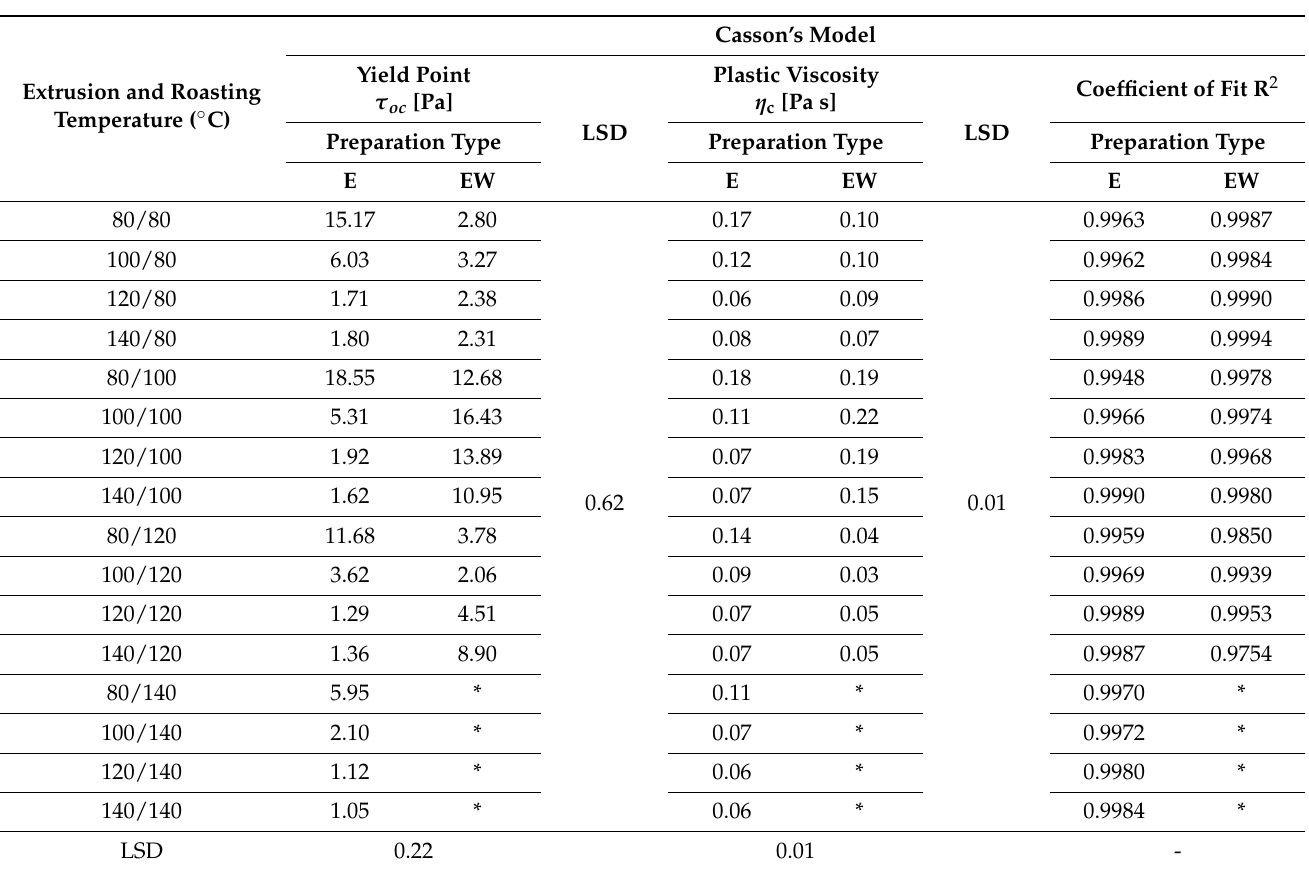
Table 3. Parameters of Casson’s model characterizing the rheological properties of pastes made from extruded and roasted starch (E) and from starch extruded with apple distillery wastewater and roasted (EW).